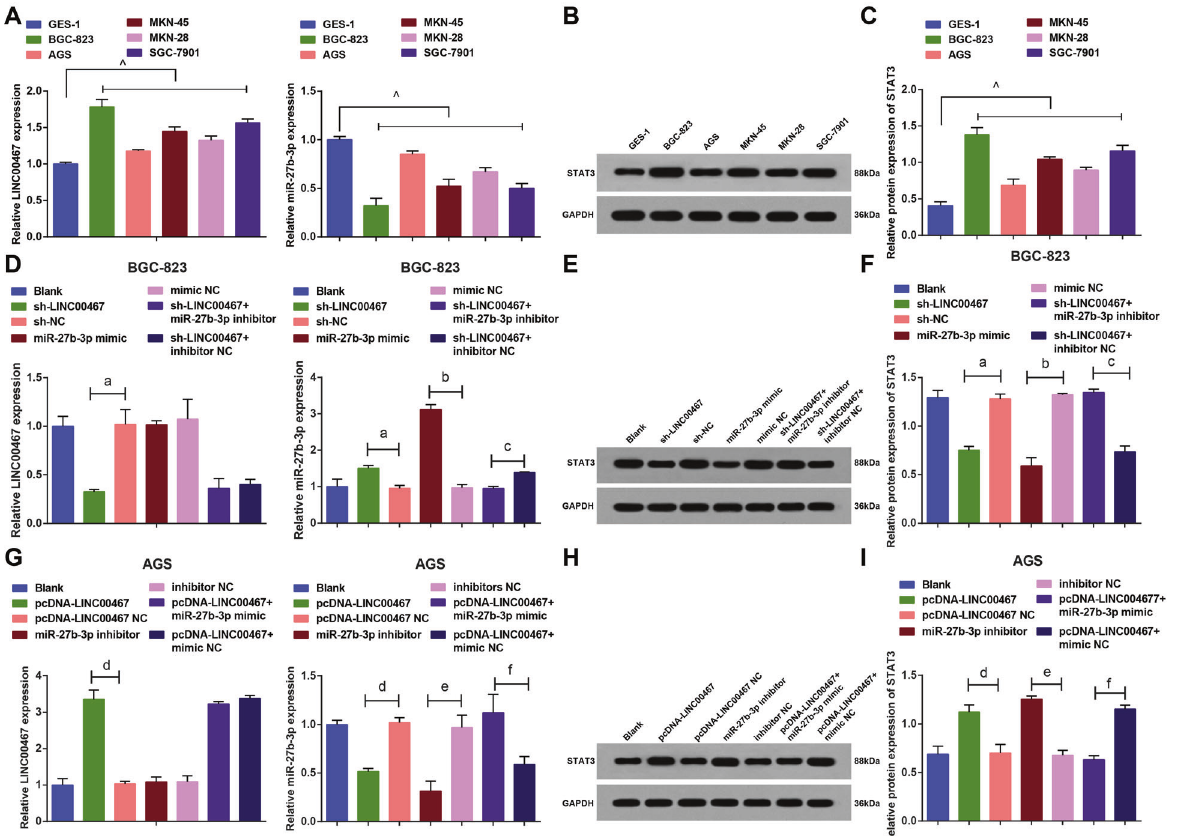
Fig. 2 LINC00467 and STAT3 are increased while miR-27b-3p is decreased in GC cells. ( A ) Expression of LINC00467, and miR-27b-3p in GES- 1 cells and GC cell lines. ( B ) Protein band of STAT3 in GES-1 cells and GC cell lines. ( C ) Protein expression of STAT3 in GES-1 cells and GC cell lines. ( D ) Expression of LINC00467, and miR-27b-3p in BGC-823 cells of each group. E Protein band of STAT3 in BGC-823 cells of each group. F Protein expression of STAT3 in BGC-823 cells of each group. G Expression of LINC00467, and miR-27b-3p in AGS cells of each group. H Protein band of STAT3 in AGS cells of each group. I Protein expression of STAT3 in AGS cells of each group; ^ P < 0.05 vs GES-1 cells; a P < 0.05 vs the sh-NC group, b P < 0.05 vs the mimic NC group, c P < 0.05 vs the sh-LINC00467 + inhibitor NC group, d P < 0.05 vs the